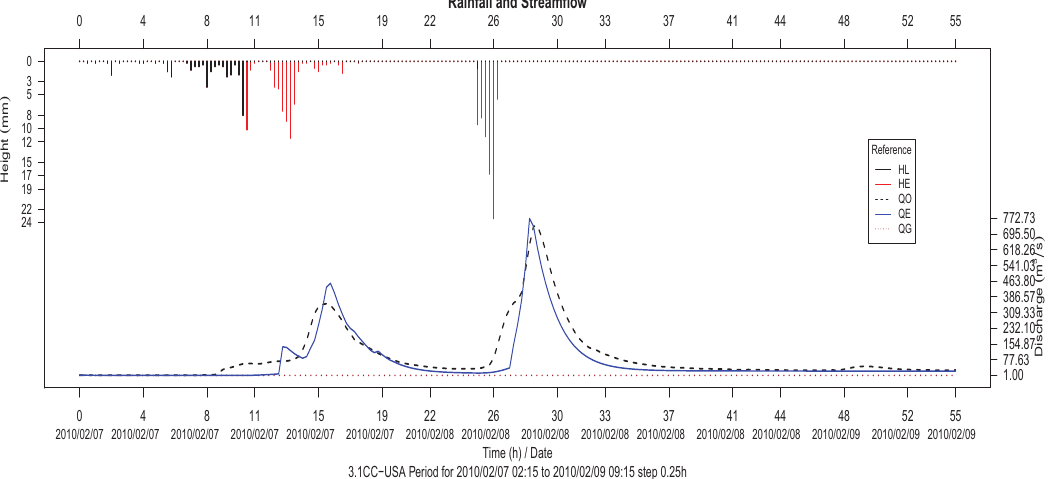
Figure 12. Hyetograph and Hydrograph from validation data series 3.1CC of San Antonio river, at Loop 410,